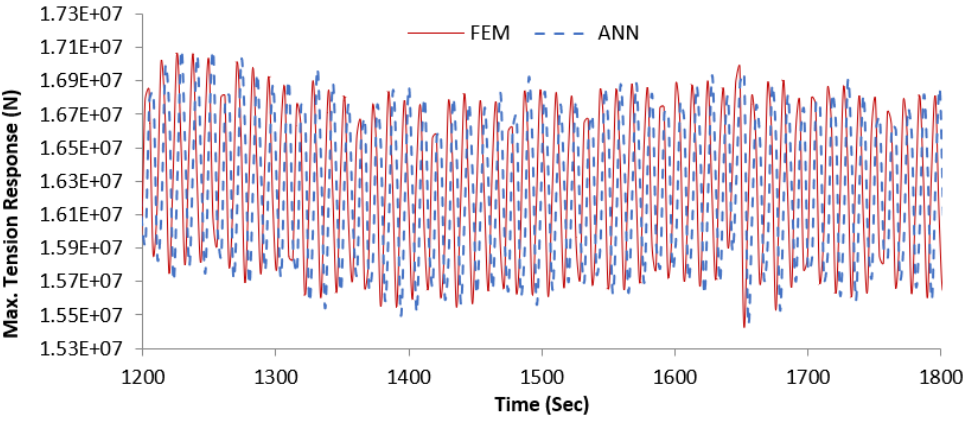
Figure 12. Mooring line tension response predicted using training data by ANN and FEM models for 12.65 m wave height and 11.39 s wave period.